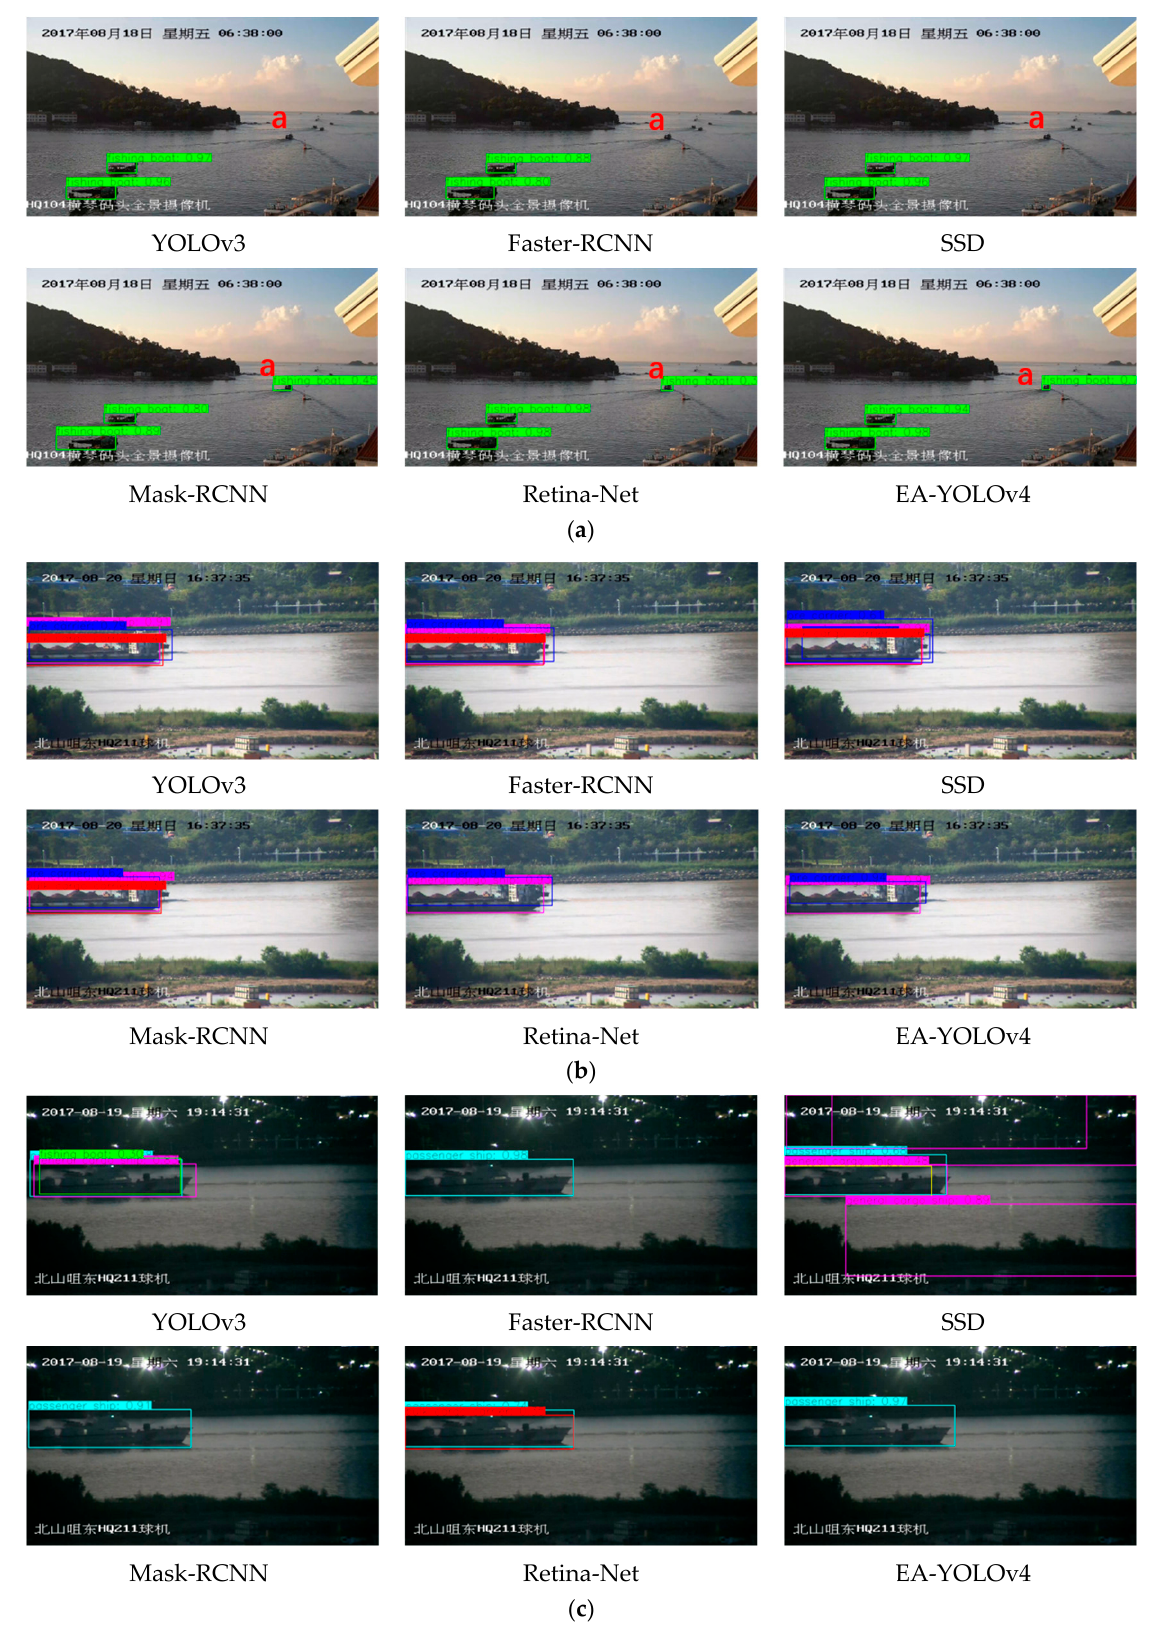
Figure 7. Ship detection results of different algorithms; ( a ) small size target scene; ( b ) multi-target overlapping scene (ore ship and general cargo ship); ( c ) underlit scene.